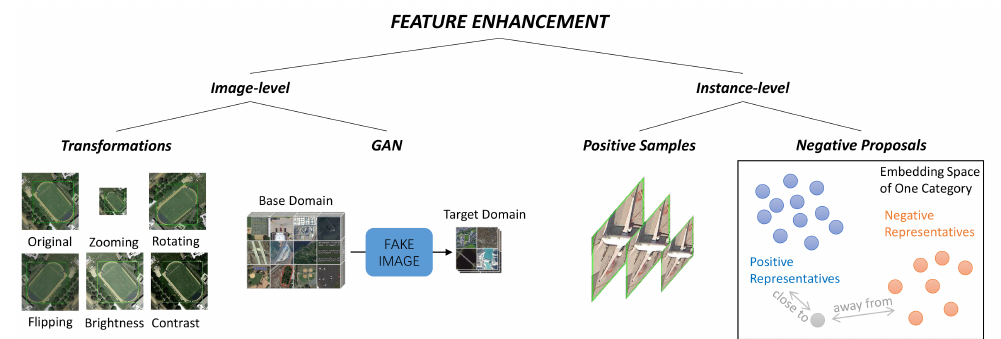
Figure 8. Principles of feature enhancement methods, including image-level and instance-level data augmentations. Details can be found in Section